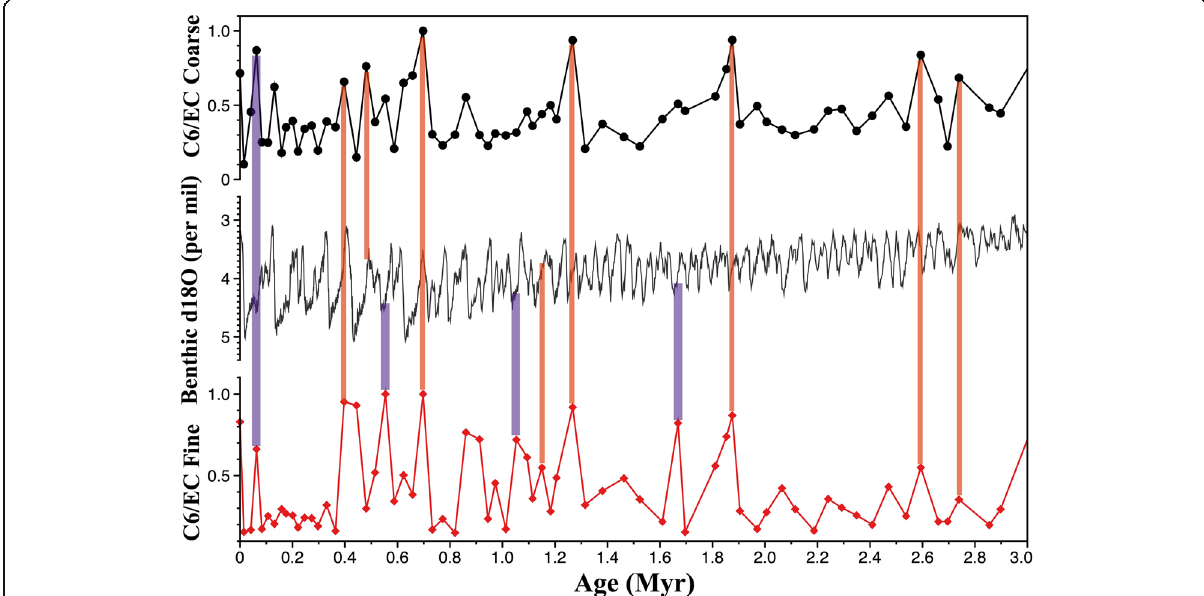
Fig. 9 LR04 standard benthic δ 18 O (Lisiecki and Raymo 2005) and C6/EC in fine and coarse fractions. The significant maxima observed in the higher temperature biomass burning proxy (C6/EC) in coarse and fine fractions are marked as blue and red vertical lines corresponding to glacial and interglacial stages,